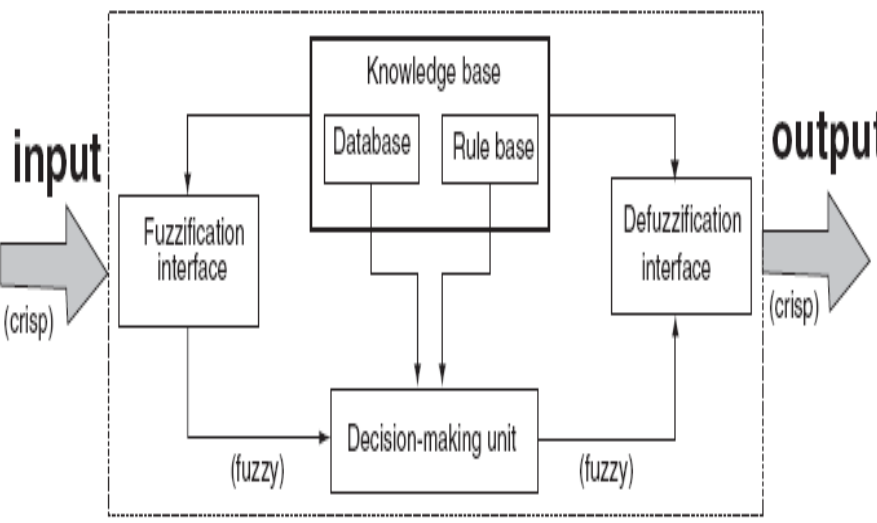
Figure 13. Block diagram representation of fuzzy pattern classification based fault